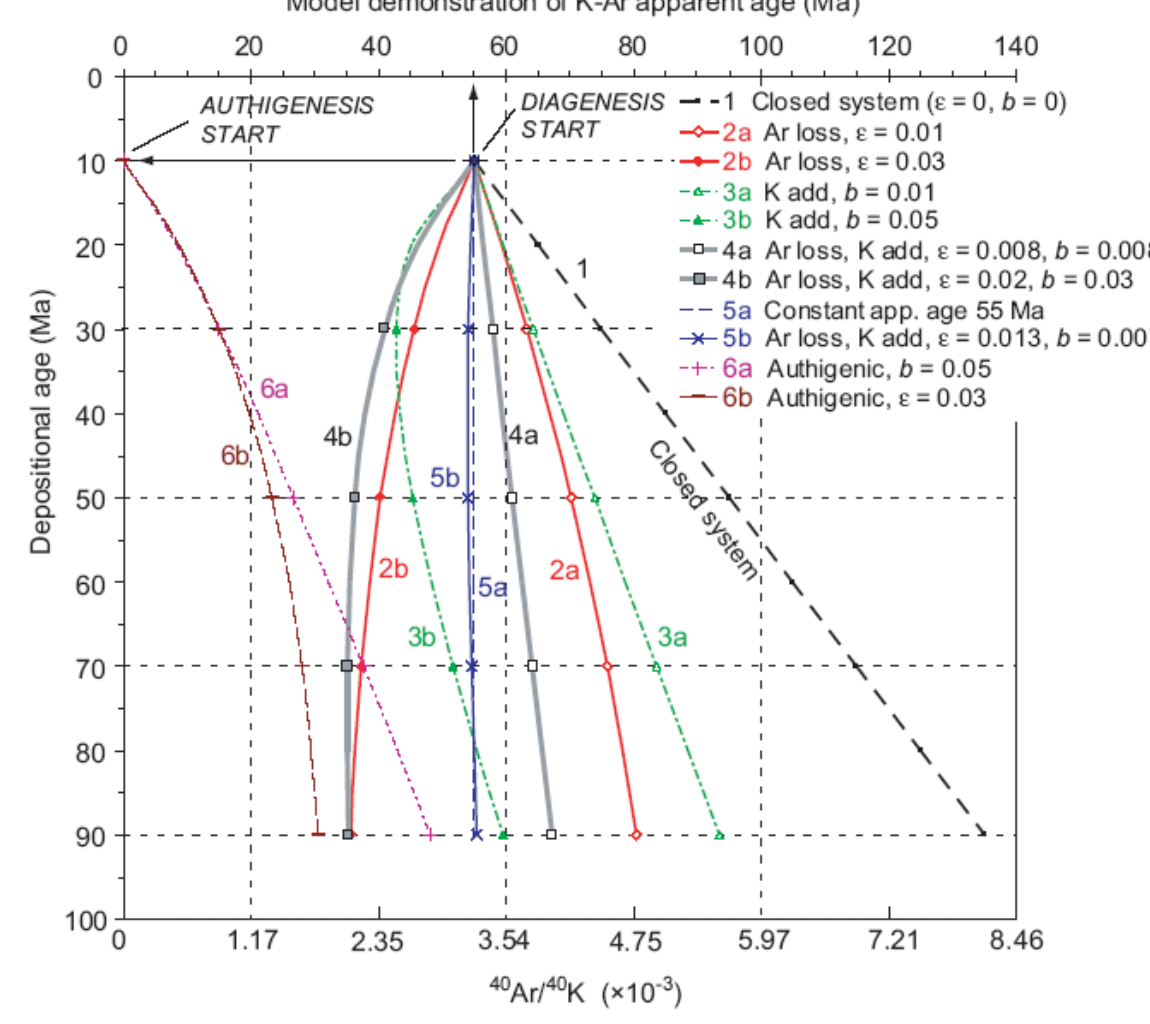
Figure 3. Illustration of the model-calculated changes in the K-Ar apparent ages due to an alteration of 55 Ma old clay particles and a precipitation of newly precipitating crystals of a 0 Ma initial K-Ar age. The increasing depositional age corresponds to increasing sediment burial depth. The theoretical closed system (curve 1) corresponds to no loss or gain of Ar and K. The single process of 40 Ar losses ( ε , Ma − 1 ) at different rates are shown in curves 2a, b, and that of K gains ( b Ma − 1 ) are shown in curves 3a, b. Two processes operating simultaneously at different rates are shown in curves 4a, b. An example of a constant K-Ar apparent age with depth (curve 5a) and its approximation by a two- process model (curve 5b) is shown. Authigenic particles gaining K (curve 6a) or losing 40 Ar (curve 6b) with time are also shown. In each case, the increase in the K-Ar apparent age is considerably smaller than if the authigenic particles were a closed system. See the Equation (A4b) in the Appendix